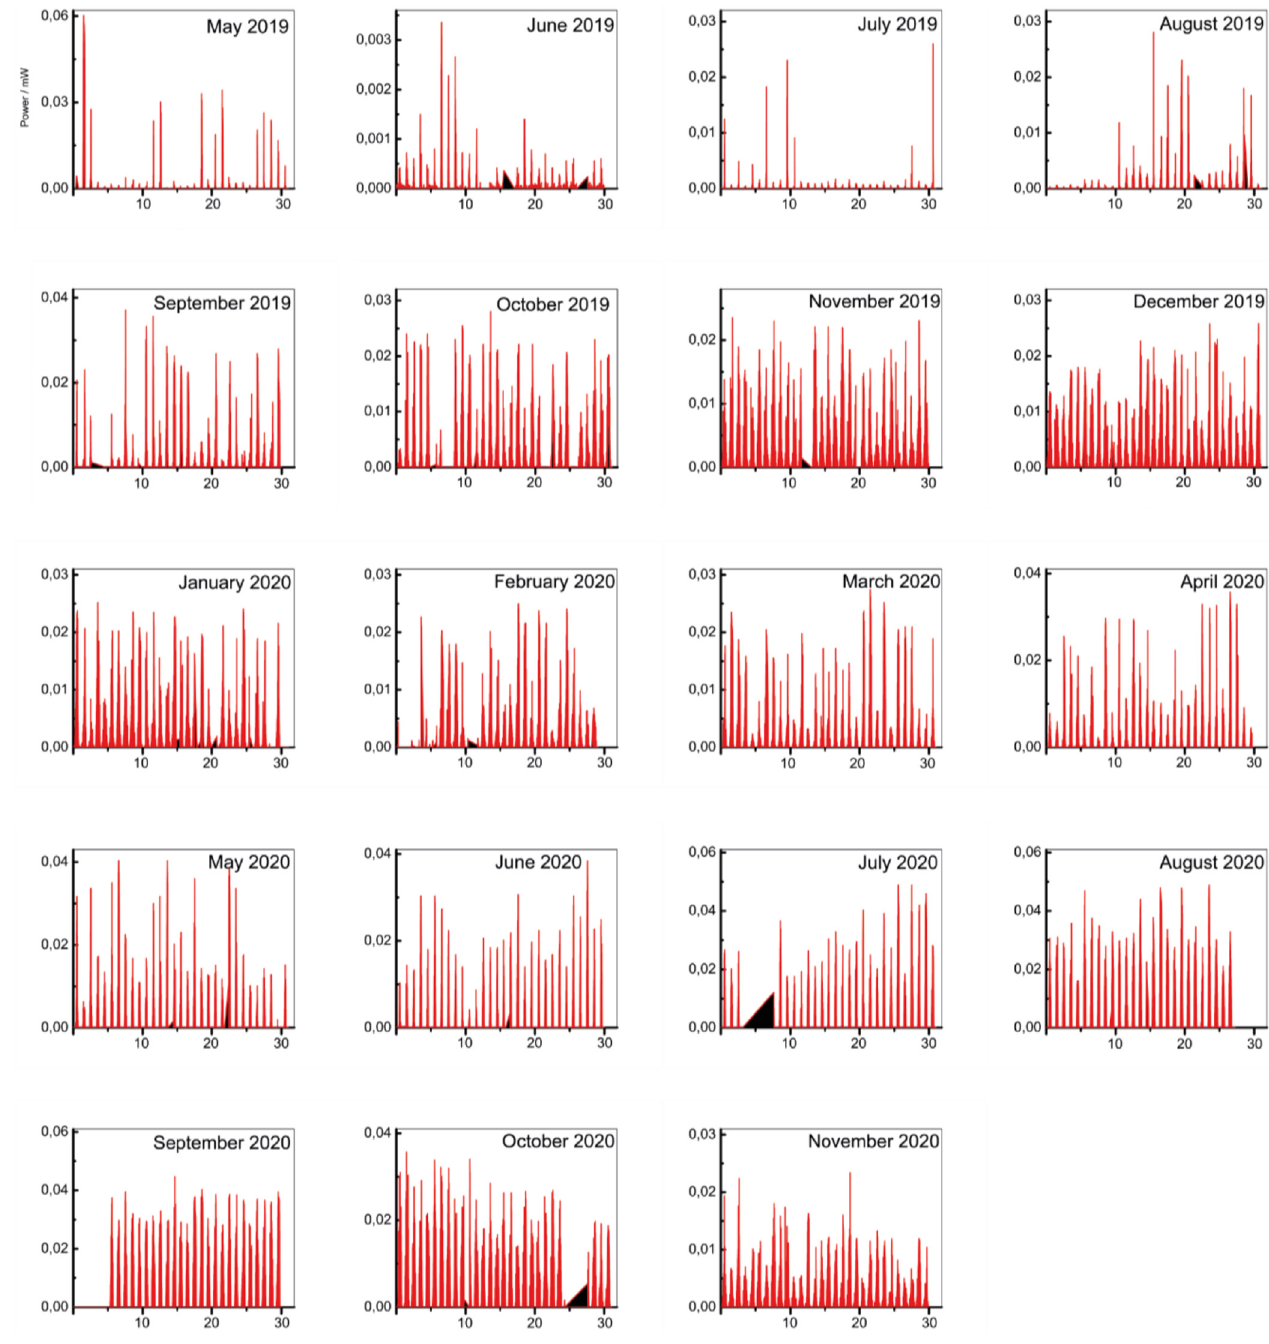
Fig. 2. The daily performance ’ s for the DSSC-panel KD12 along the whole period of the test. The module was placed in front of a window inside one of the Artigas Antarctic Base